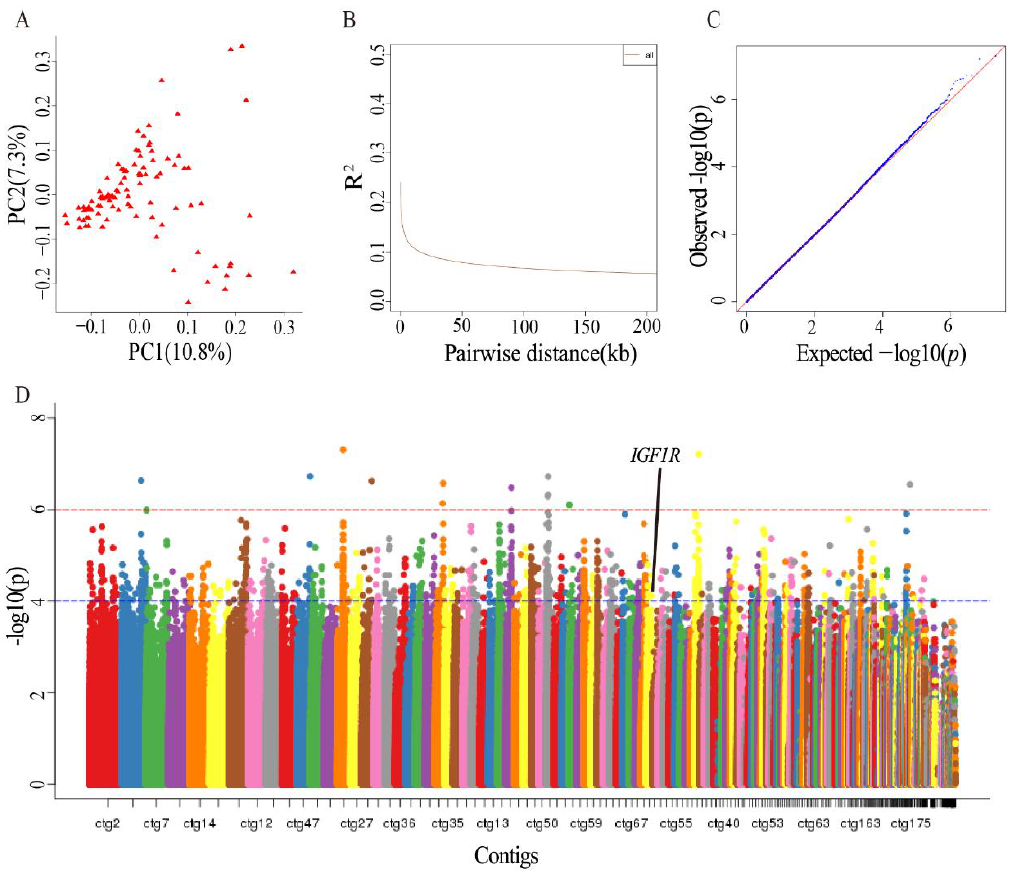
Figure 1. The GWAS of SNPs related to antler growth rate: ( A ) The analyzed population was a natural population and did not form significant genetic differentiation. ( B ) A value of 20 kb was set as the LD value of GWAS. ( C ) Most of the observed and expected values of the p -value are the same, which indicates that the analysis model is reasonable. The point above the diagonal in the upper right corner is a significant site, but it does not exceed the expected value. ( D ) When the p value ≥ 1 × 10 −6 (shown by the red dotted line), only 13 associated SNPs were obtained; when p value ≥ 1 × 10 −4 (shown by the blue dotted line), 1182 associated SNPs were obtained.